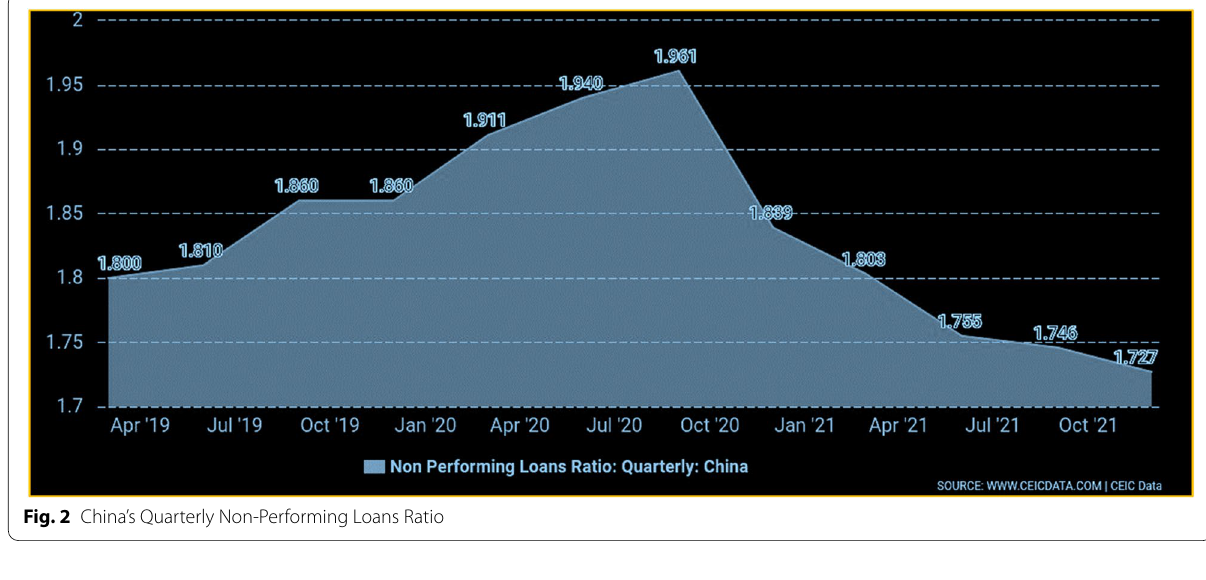
Fig. 2 China’s Quarterly Non-Performing Loans Ratio